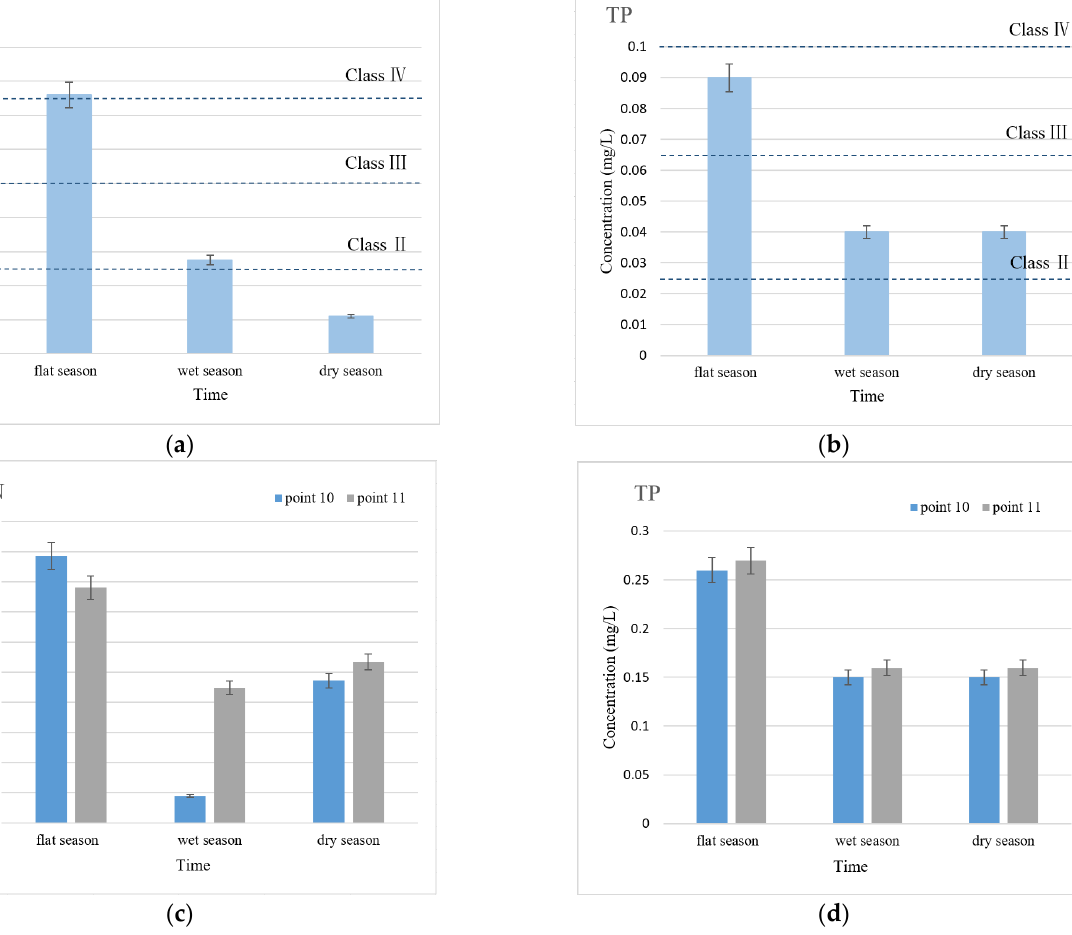
Figure 5. TN and TP concentration in Taihu Lake and Beijing–Hangzhou Grand Canal. ( a , b ) Point 9 at Taihu Lake; ( c , d ) Point 10 and point 11 at Beijing–Hangzhou Grand Canal.